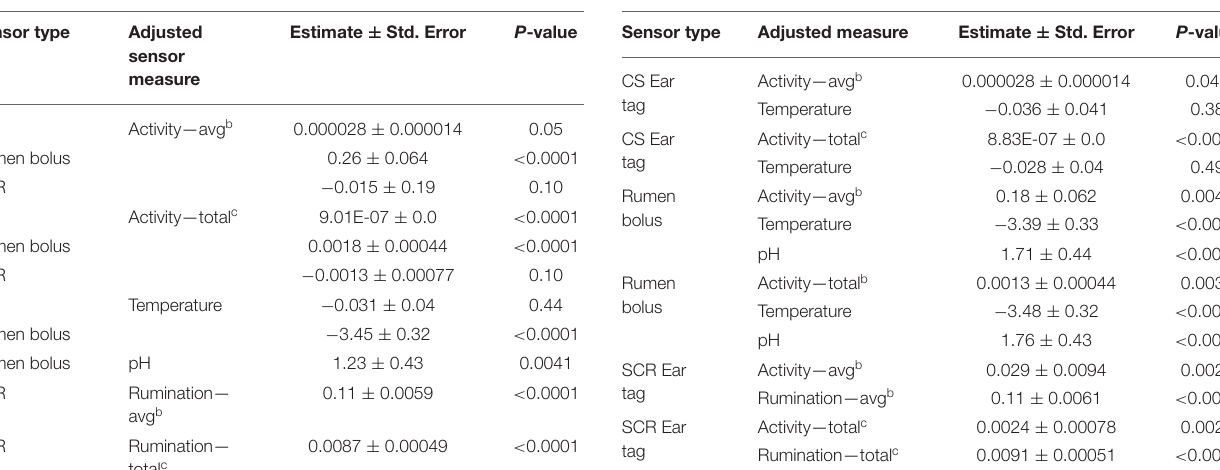
TABLE 5 | Association of sensor measurements a with dry mater intake from models including only one type of measurement from each sensor. Sensor type